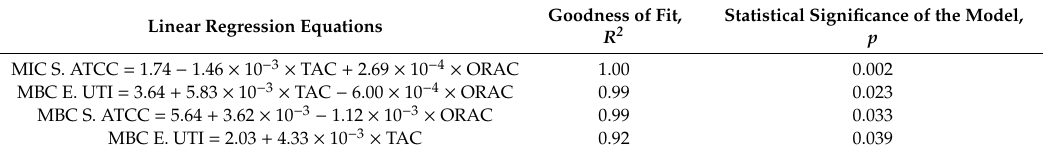
Table 7. Regression of antibacterial activity (MIC and MBC) variables and the total anthocyanin content (TAC) of the four varieties of blueberries, and the antioxidant capacity, as assessed by the ORAC. Goodness of Fit, Statistical Significance of the Model, Linear Regression Equations R 2